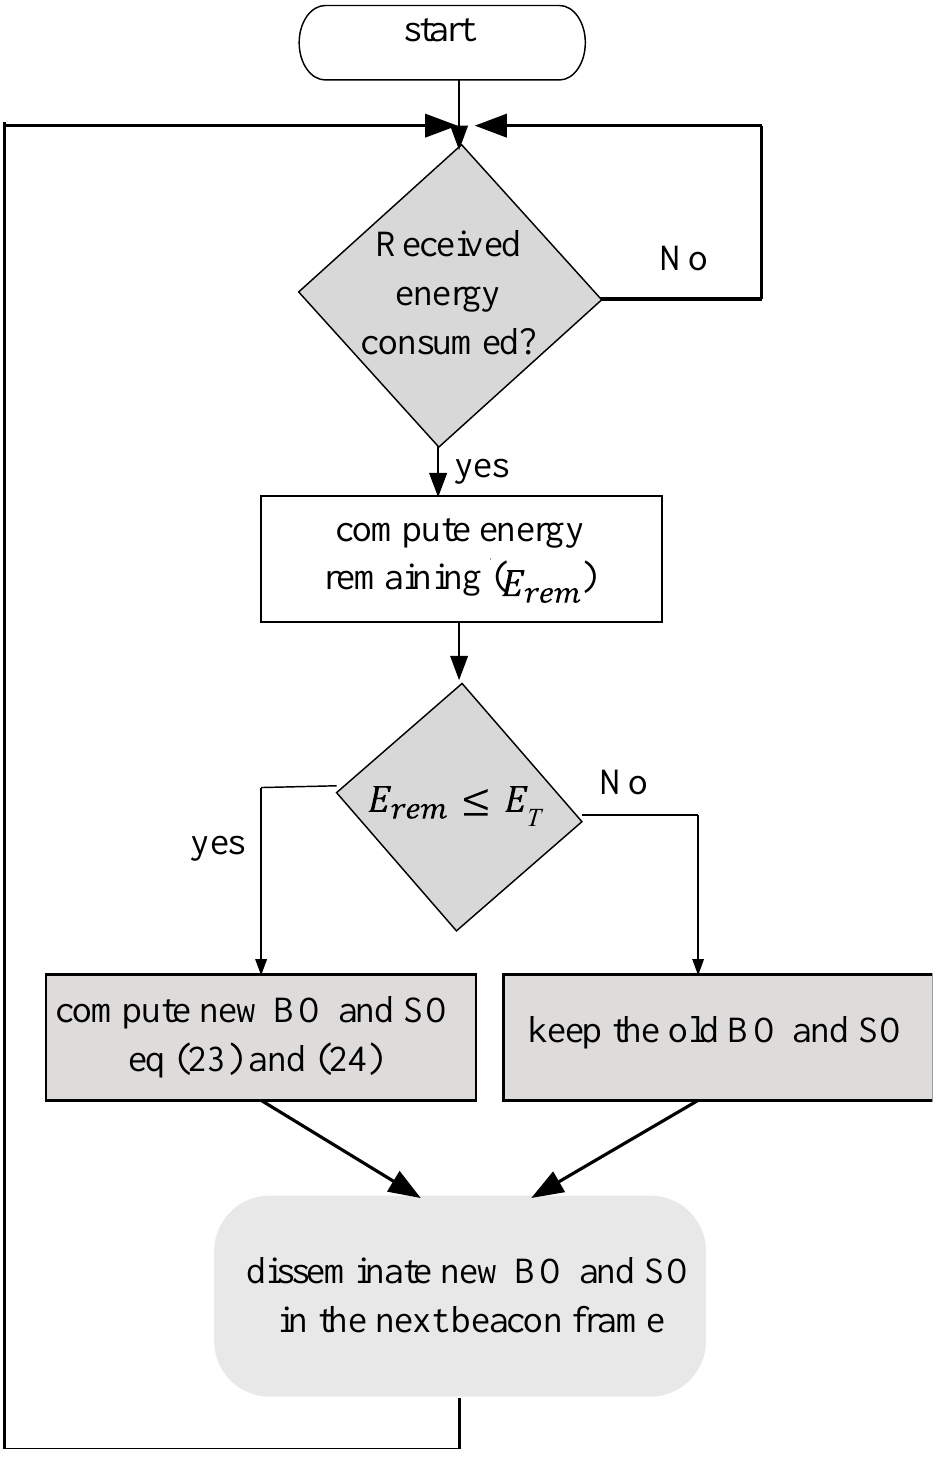
Figure 4. Flowchart of duty-cycle adjustment algorithm for IEEE 802.15.4.